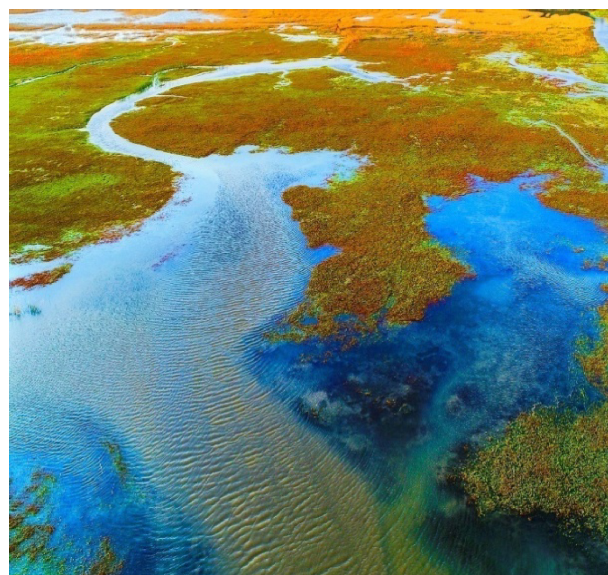
Figure 1. Suaeda heteroptera in the Liao River